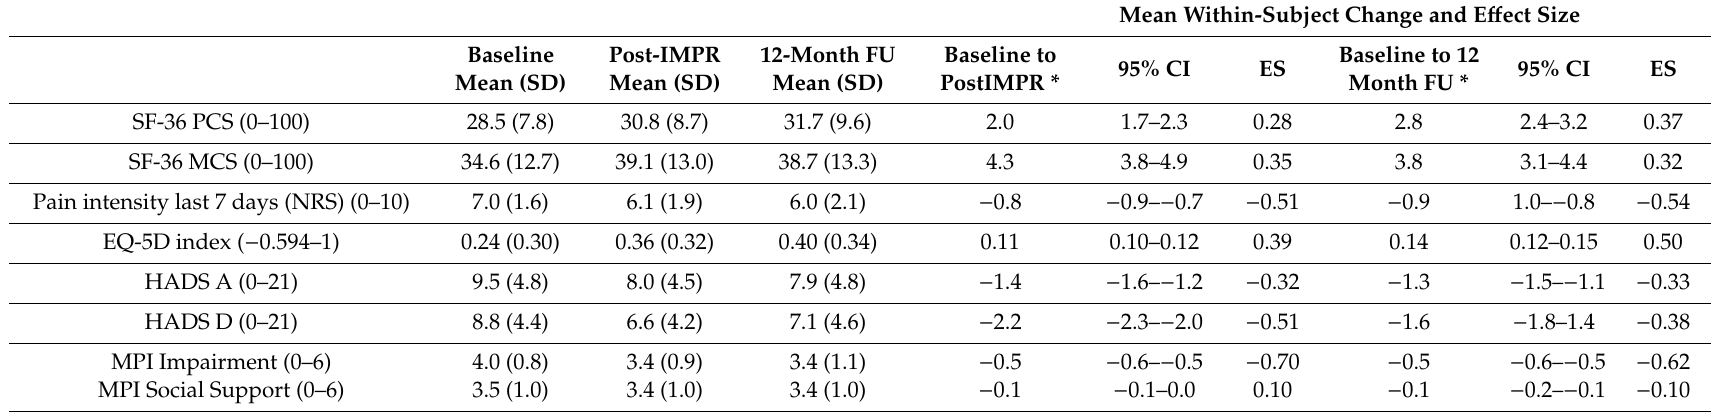
Table 2. Within-group results at baseline and after completion of an interdisciplinary multimodal pain rehabilitation (IMPR) program, and at 12-month follow-up